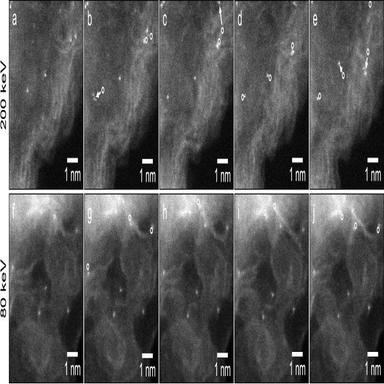
HAADF-STEM image series of the FeReNC SAE taken using a (a-e) 200 keV and (f-j) 80 keV electron probe. Under the 200 keV probe, Re atoms are readily displaced, while at 80 keV Re atoms are significantly more stable. White circles indicate previous positions of Re atoms that moved a distance equal to or greater than the apparent diameter of the atom between images shown, with large movements indicated by white arrows.